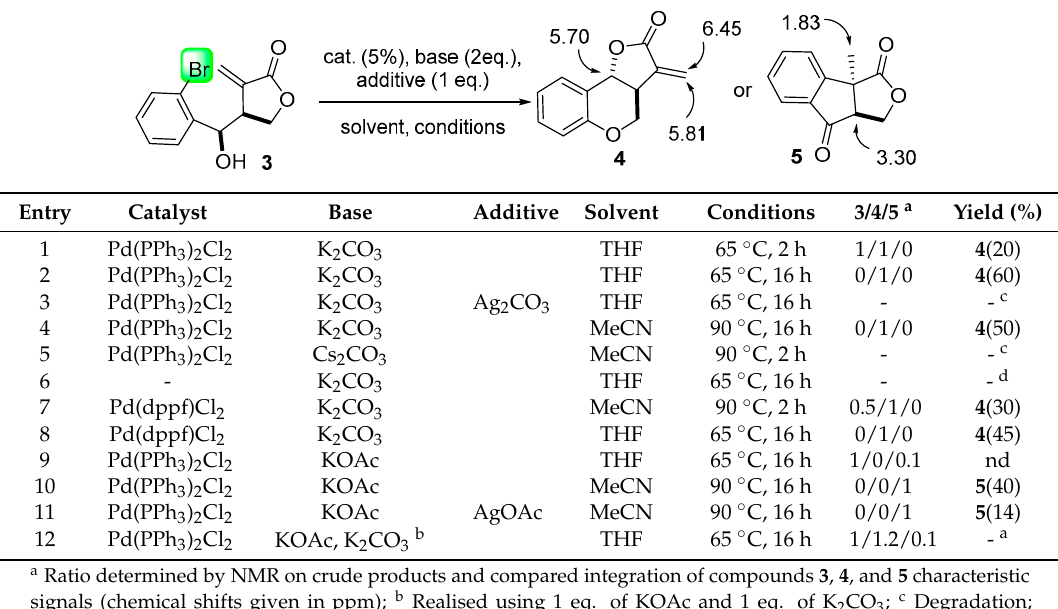
Table 1. Selective access to lactones 4 and 5 .